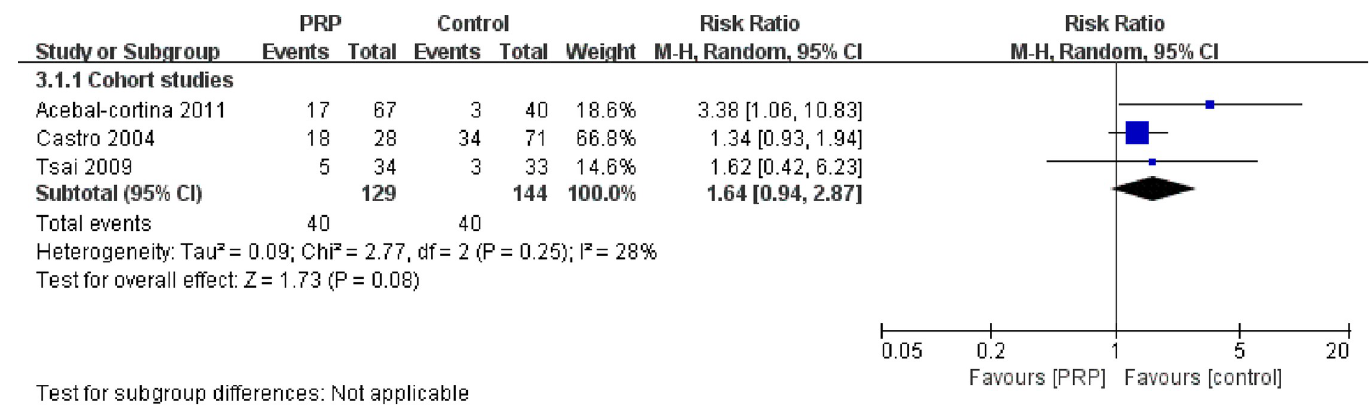
Fig 4. Forest plot of complications in the cohort studies.